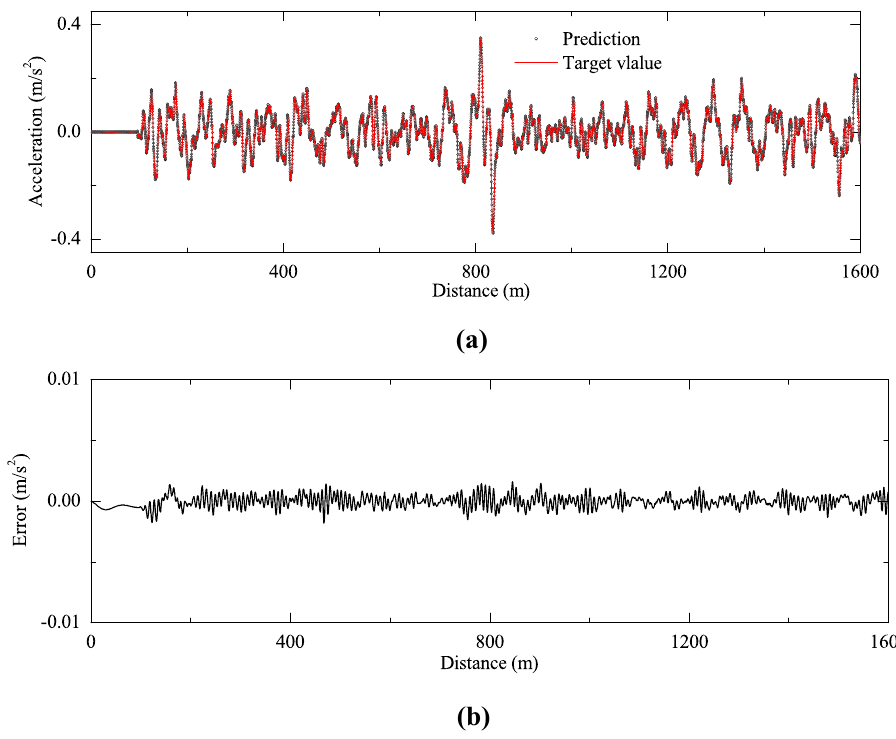
Fig. 9 Comparison of the predicted value of the surrogate model and the target value: a time history of acceleration and b